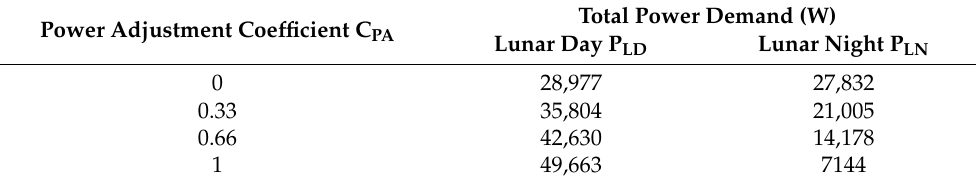
Table 18. The lunar base power loads for various power management